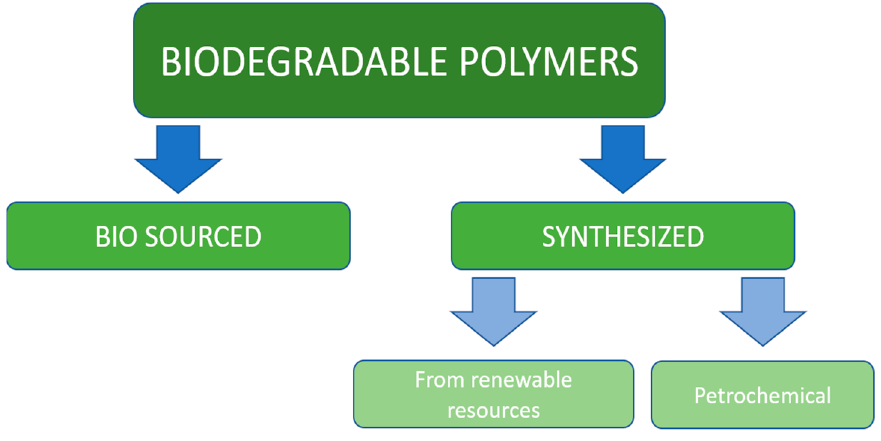
Figure 1. Classification of biodegradable polymers.